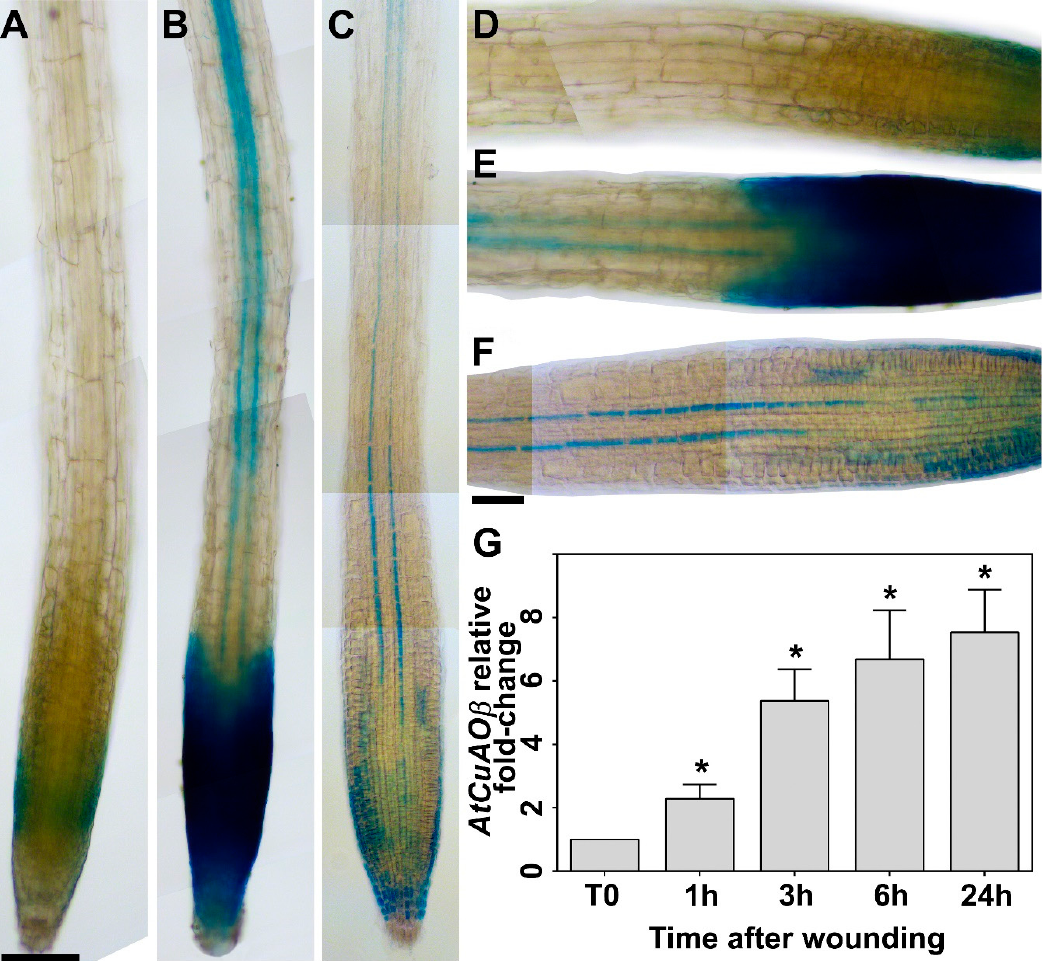
Figure 1. Analysis of AtCuAO β gene expression upon leaf wounding by GUS staining analysis (root) and RT ‐ qPCR (whole seedlings). ( a – f ) Light microscopy analysis after GUS staining of roots from 7 ‐ day ‐ old AtCuAO β‐ promoter::GFP ‐ GUS seedlings unwounded ( a – f ) or leaf ‐ wounded after 3 h from the injury ( b , e ). The staining reaction was allowed to proceed for 2 h ( a , d unwounded, and b , e wounded leaf) or overnight ( c , f ; unwounded). Shown images were obtained aligning serial overlapping micrographs of the same root using Photoshop Software (Adobe). Ten plants from three independent experiments were analyzed and images from a single representative experiment is shown. Bar: 200 μ m ( a – c ); 100 μ m ( d – f ). ( g ) RT ‐ qPCR analysis in 7 ‐ day ‐ old wild type (WT) whole seedlings at 0, 1, 3, 6 and 24 h time ‐ points from cotyledonary leaf injury. Three biological replicates each with three technical replicates were performed ( n = 3). AtCuAO β mRNA level after wounding is relative to that of the corresponding unwounded plant for each time point. The significance levels ( p ‐ values) between the relative mRNA level at each time and the mRNA level of control unwounded plant at time 0 (T0), which is assumed to be one, have been calculated with one ‐ way analysis of variance (ANOVA) followed by Sidak’s multiple comparison test (*; p ‐ values ≤ 0.05).